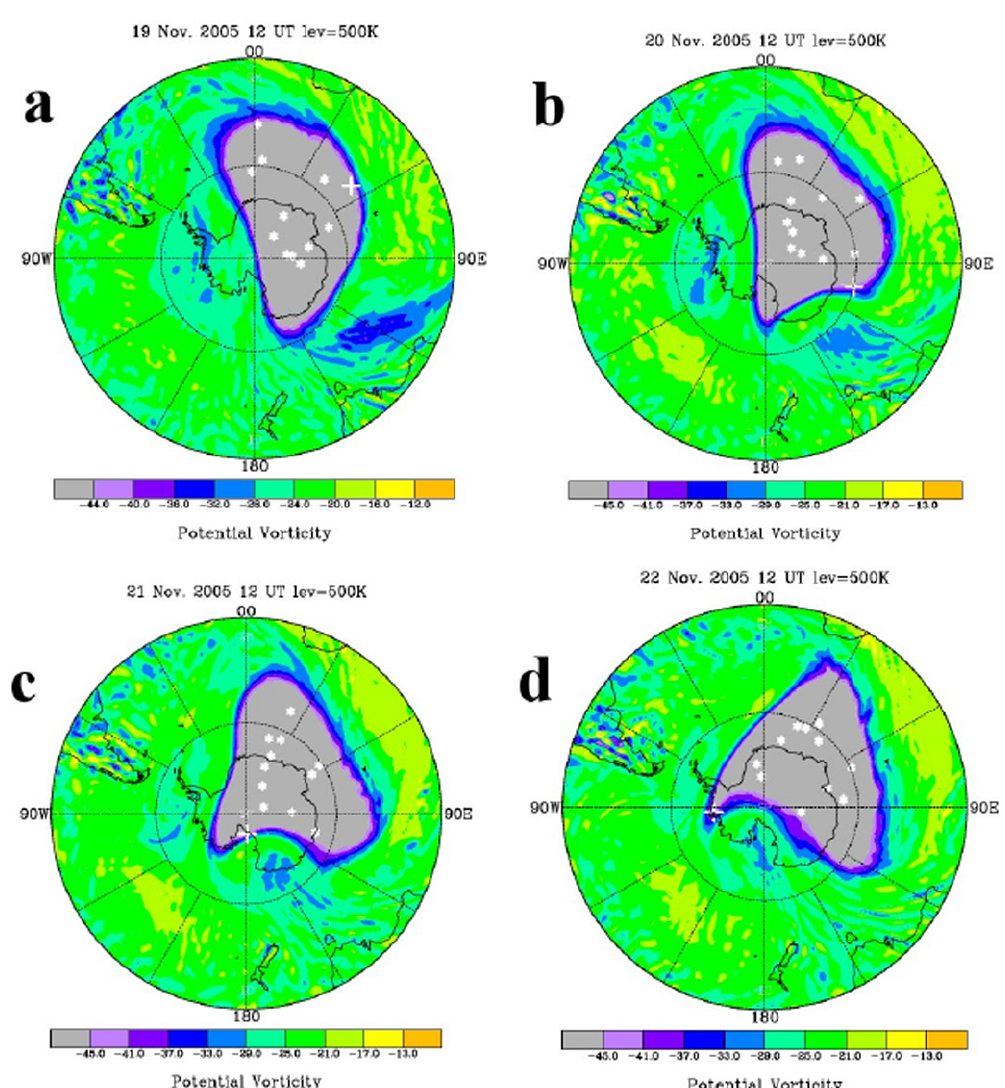
Fig. 1a–d. A sequence for the potential vorticity fields obtained from ECMWF at 500K level on (a) 19, (b) 20, (c) 21, and (d) 22 Novem- ber 2005 at 12:00UTC. The contour interval is 4PVU. The crosses superimposed in this figure indicate the locations of the balloon that was launched on 28 October 2005 and was ejected from the vortex. The stars denote locations of several balloons that evolved inside the vortex during the same